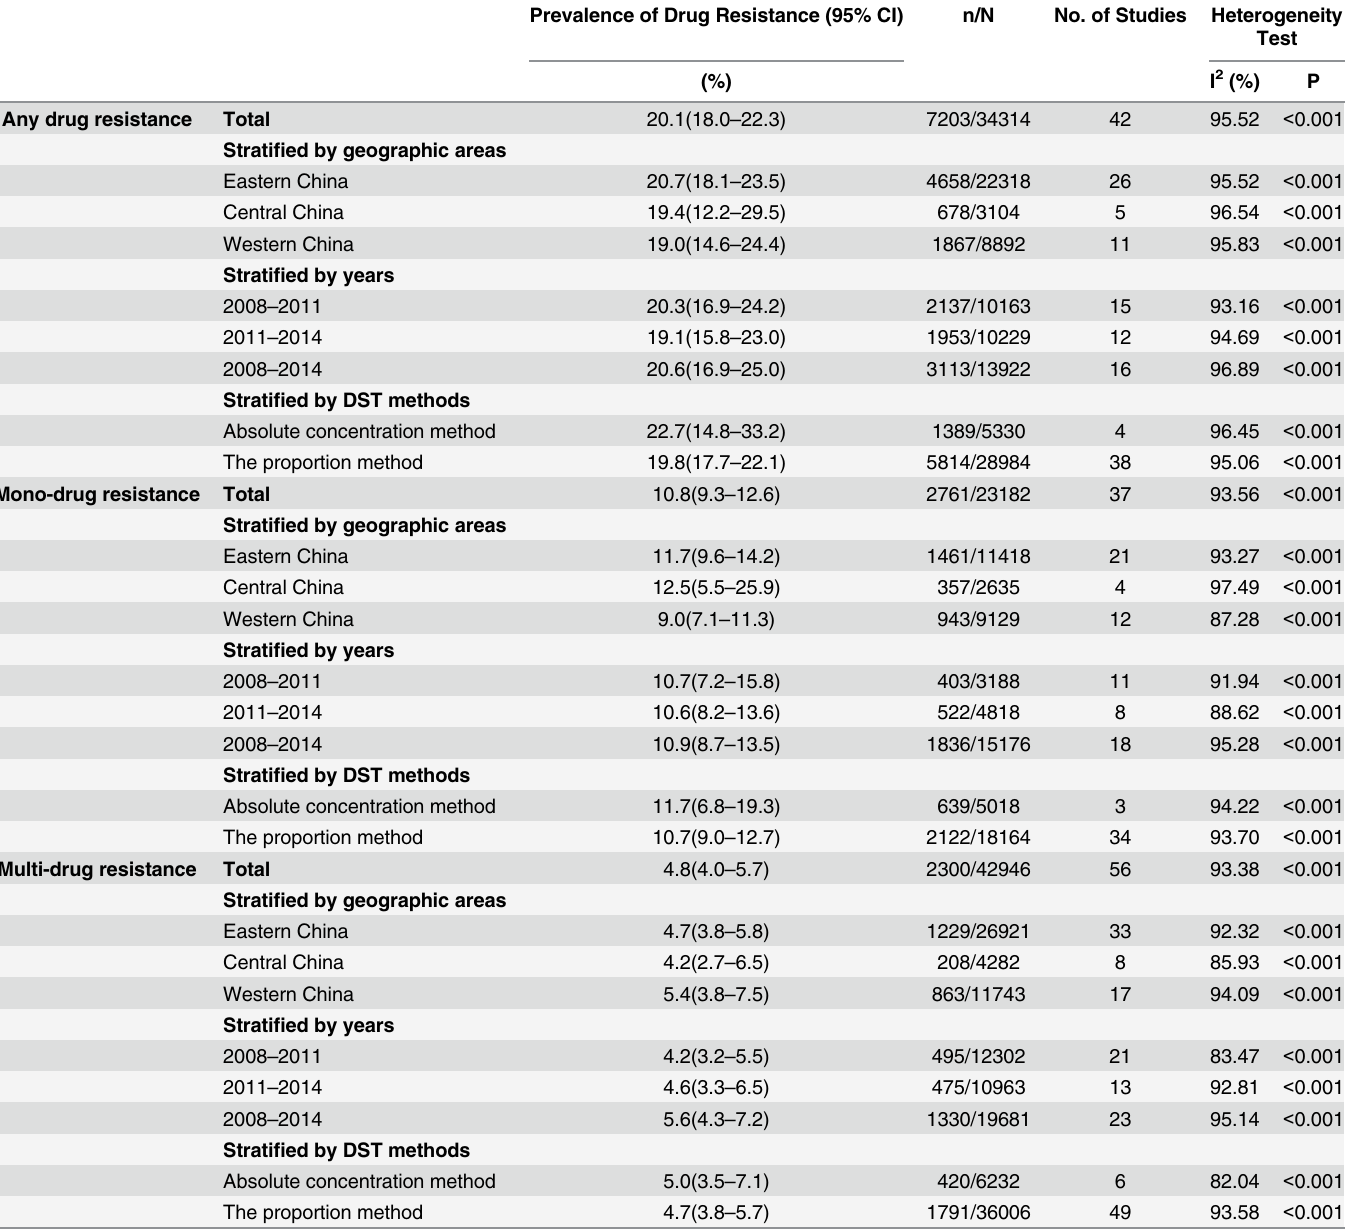
Table 1. Pooled prevalence of drug resistant tuberculosis among new cases in China. Prevalence of Drug Resistance (95% CI)